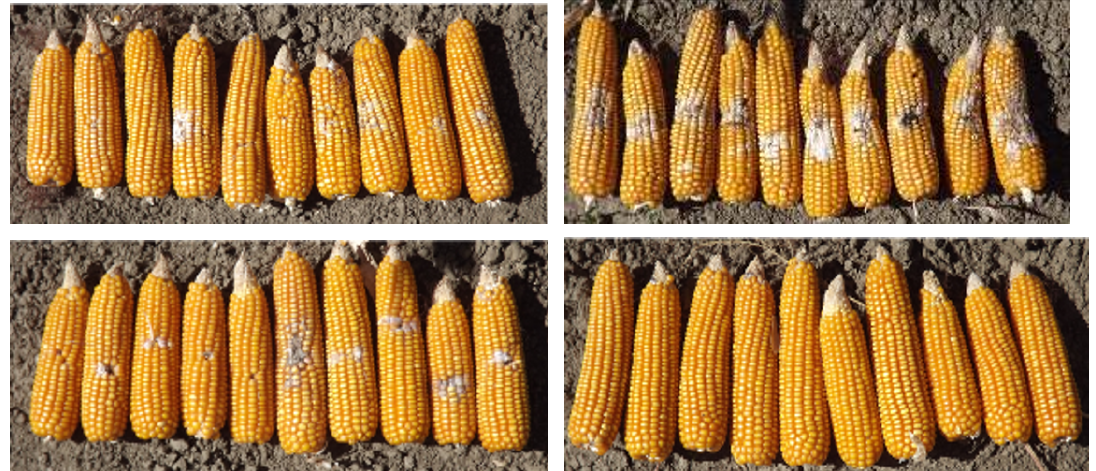
Figure 3. Resistance of hybrid Sze 363 against different Fusarium spp. Toothpick method, kernel resistance. ( Left upper ): F. graminearum , ( right upper ): F. culmorum , ( left lower ): F. verticillioides, ( right lower ): naturally infected control.